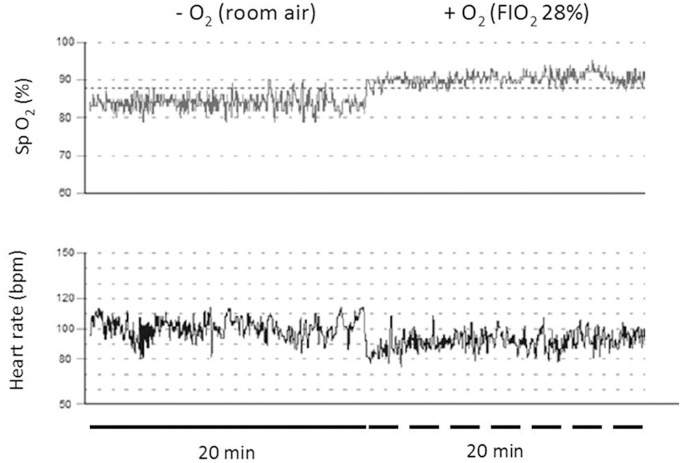
Representative records of subjects tested at Chajnantor valley's (5,050 m) when breathing air alone (thin line pulse oximetry and thick line heart rate). The thick and segmented lines represent recording of 20 min without and with oxygen, respectively.